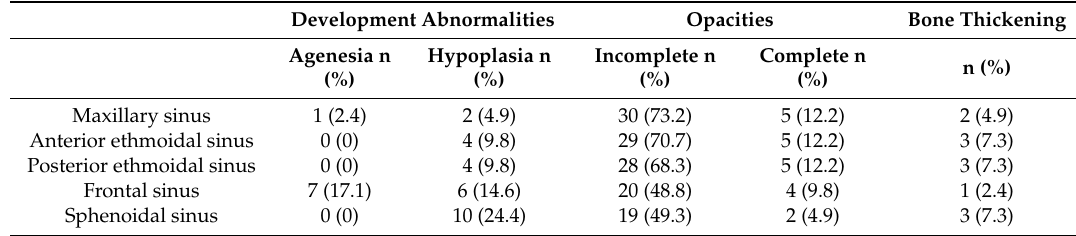
Table 2. Sinus computed tomography (CT) characteristics ( n = 41).